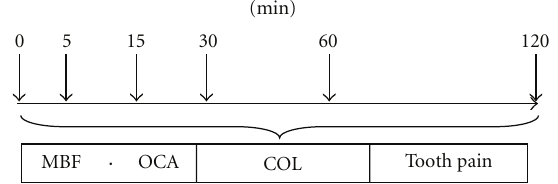
Figure 4: Schematic illustration to show the time course.